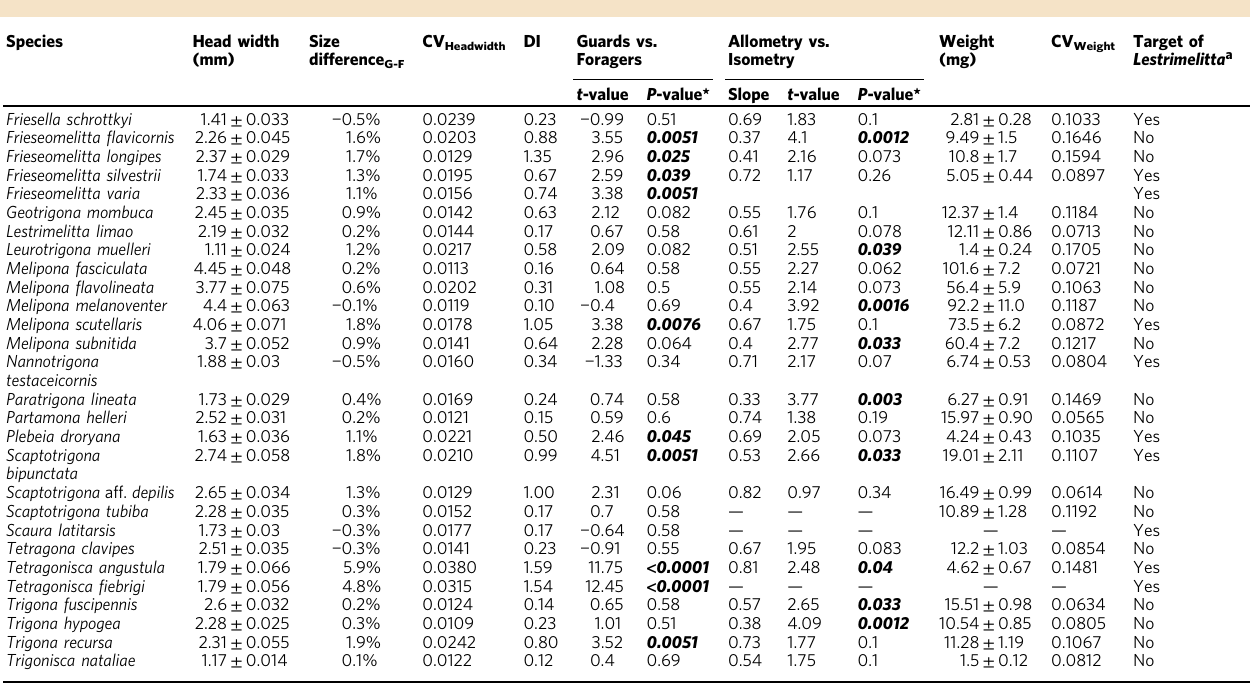
Allometry vs. Isometry